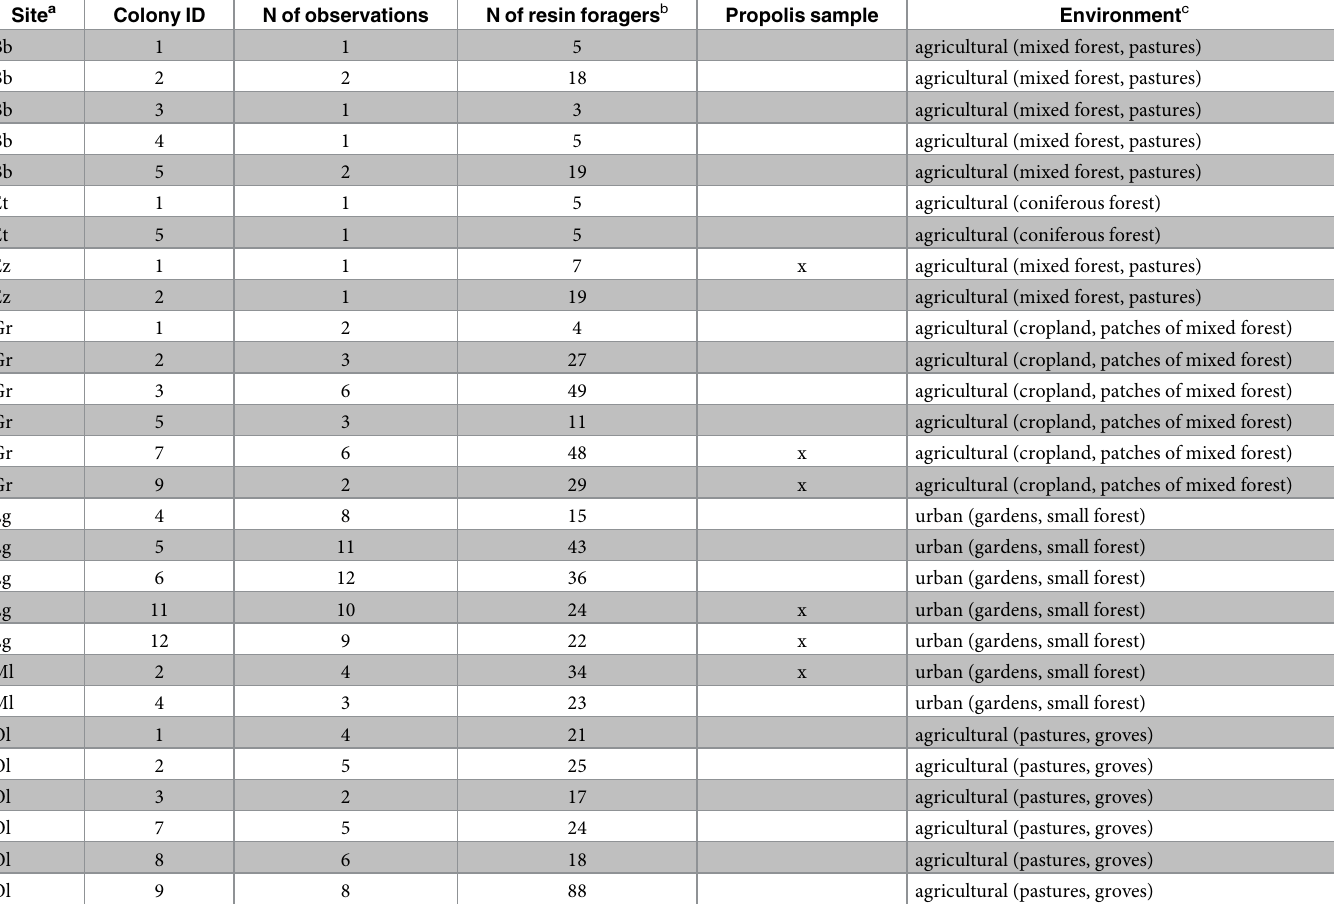
Table 1. Overview of the study sites and honeybee